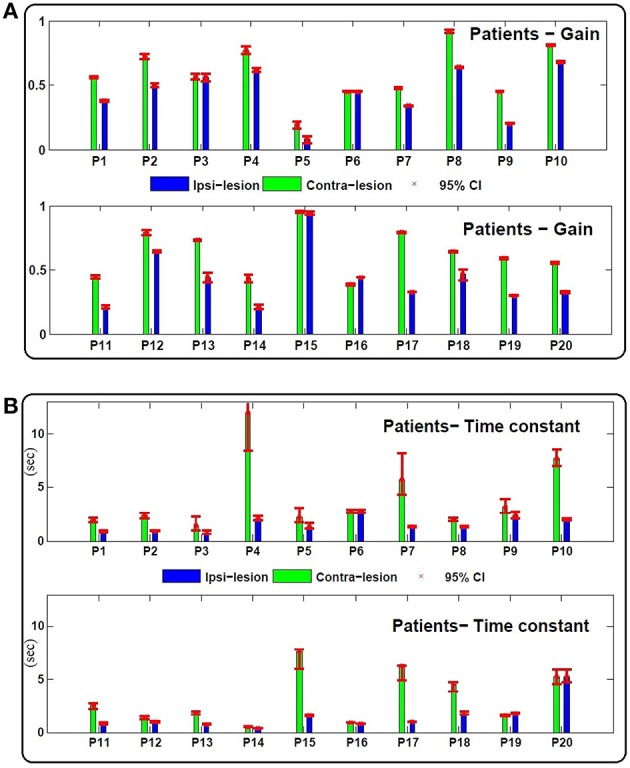
(A) Estimated gain (gco, gip) and (B) central processing time constant (Tco, Tip) values for contra and ipsi-lesion rotations in 20 unilateral vestibular patients (P1 − P20). Ninety-five percent confidence intervals of the estimated values are shown with red bars which are computed based a Monte Carlo study from 200 repetitions of parameter estimates from randomly selected data intervals in the record—each sample set had the same number of data points.